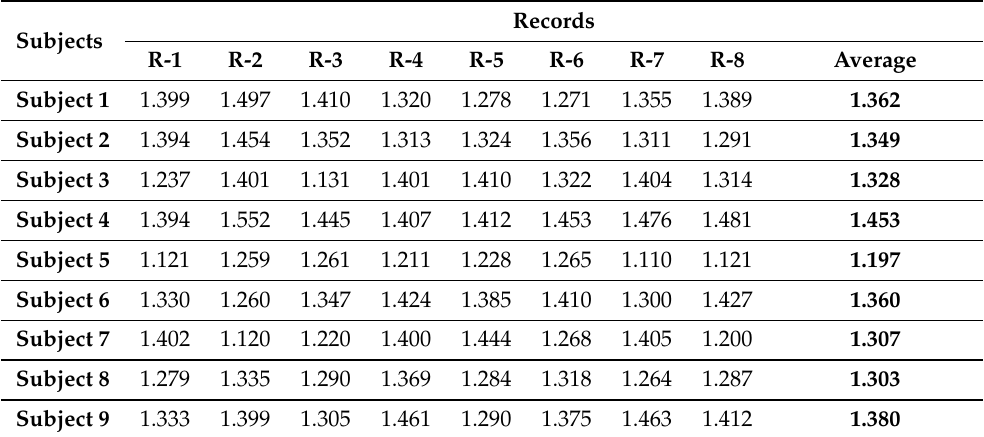
Table 3. SAR values of real EEG signals.